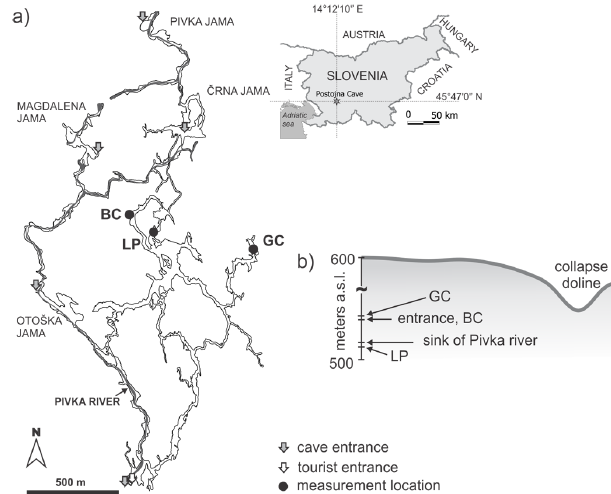
Fig. 1. Postojna Cave System. (a) ground plan of the Postojna Cave System with marked monitoring sites: Lepe jame (BC), the lowest point (LP) and the Pisani rov (GC); (b) the level of measurement